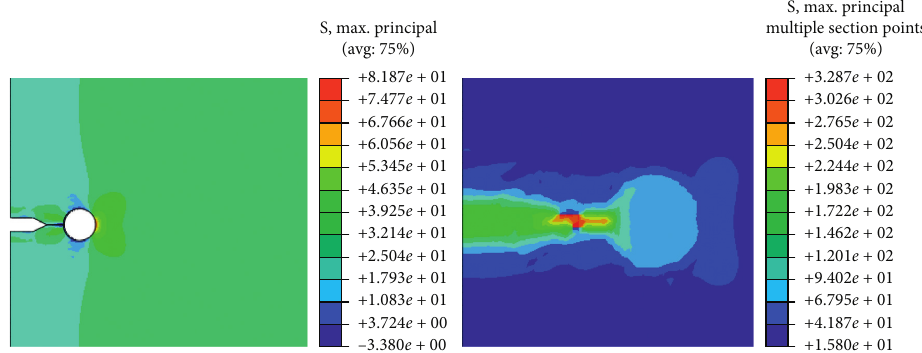
Figure 11: Stress contour of steel plate and CFRP patch